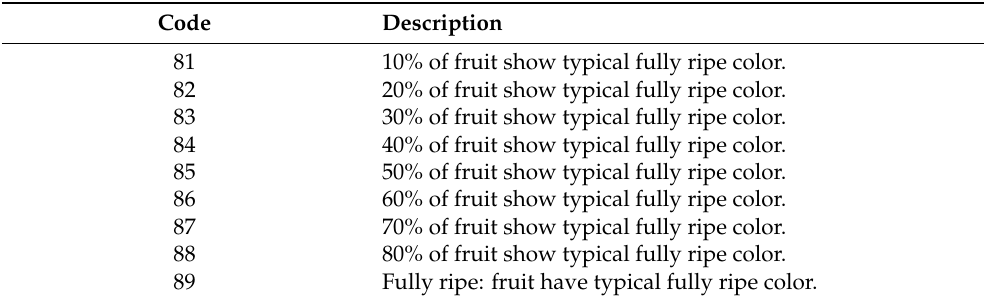
Table 7. Description of the principal stage 8 (ripening of fruit and seeds) of slender nightshade, based on the BBCH scale.